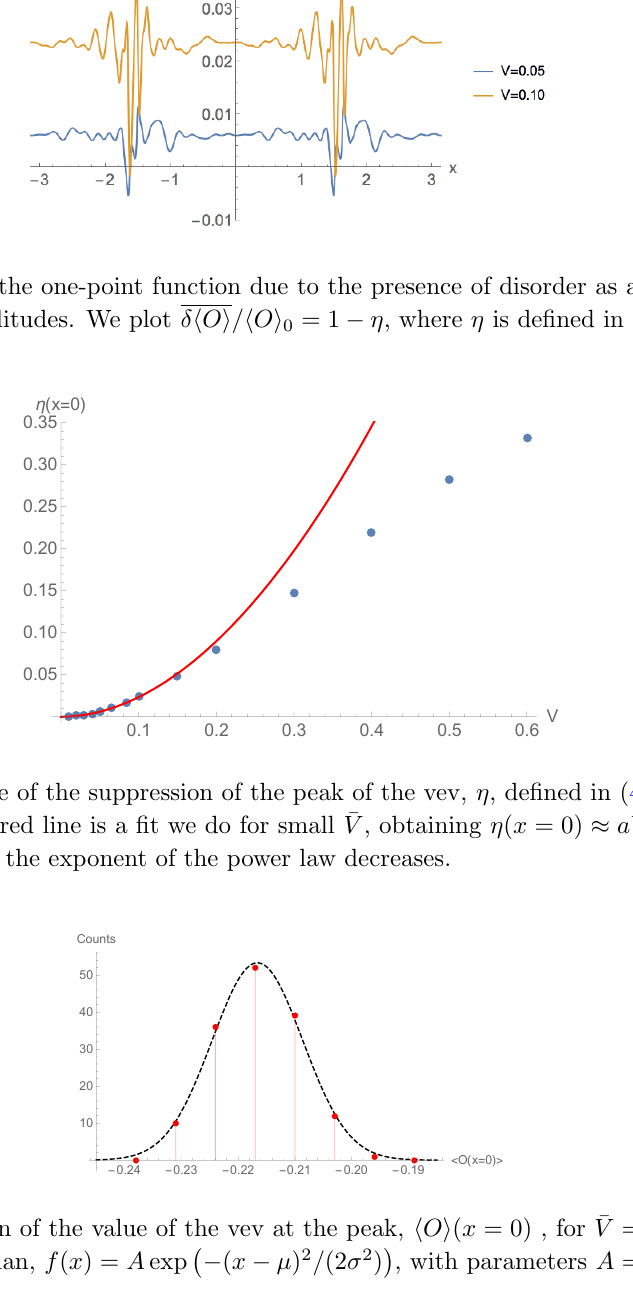
(cid:0) (cid:1) (cid:0) ( x (cid:0) (cid:22) ) 2 = (2 (cid:27) 2 ) , with parameters A = 53 : 3, (cid:22) = (cid:0) 0 : 21,